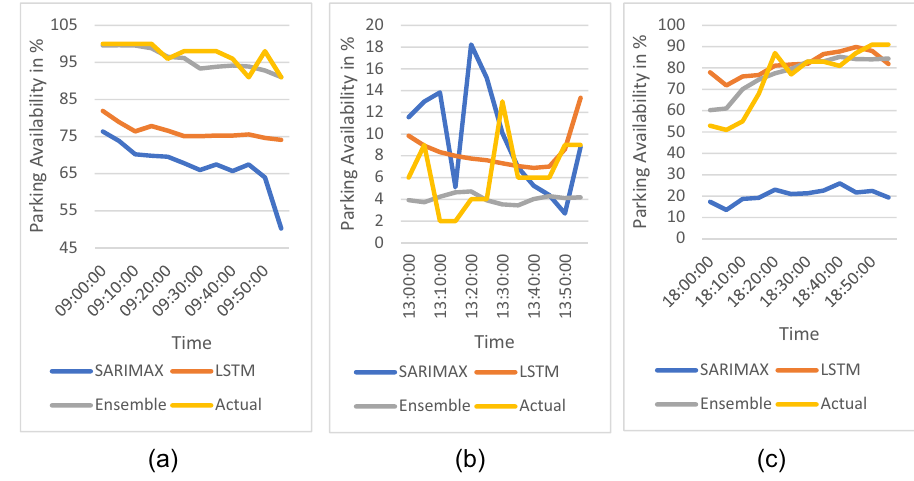
Figure 4: Prediction plot of methods with visitor trend data on the weekend. ( a ) Predictions with visitor trend data at 9 AM on weekend. ( b ) Predictions with visitor trend data at 1 PM on weekend. ( c ) Predictions with visitor trend data at 6 PM on